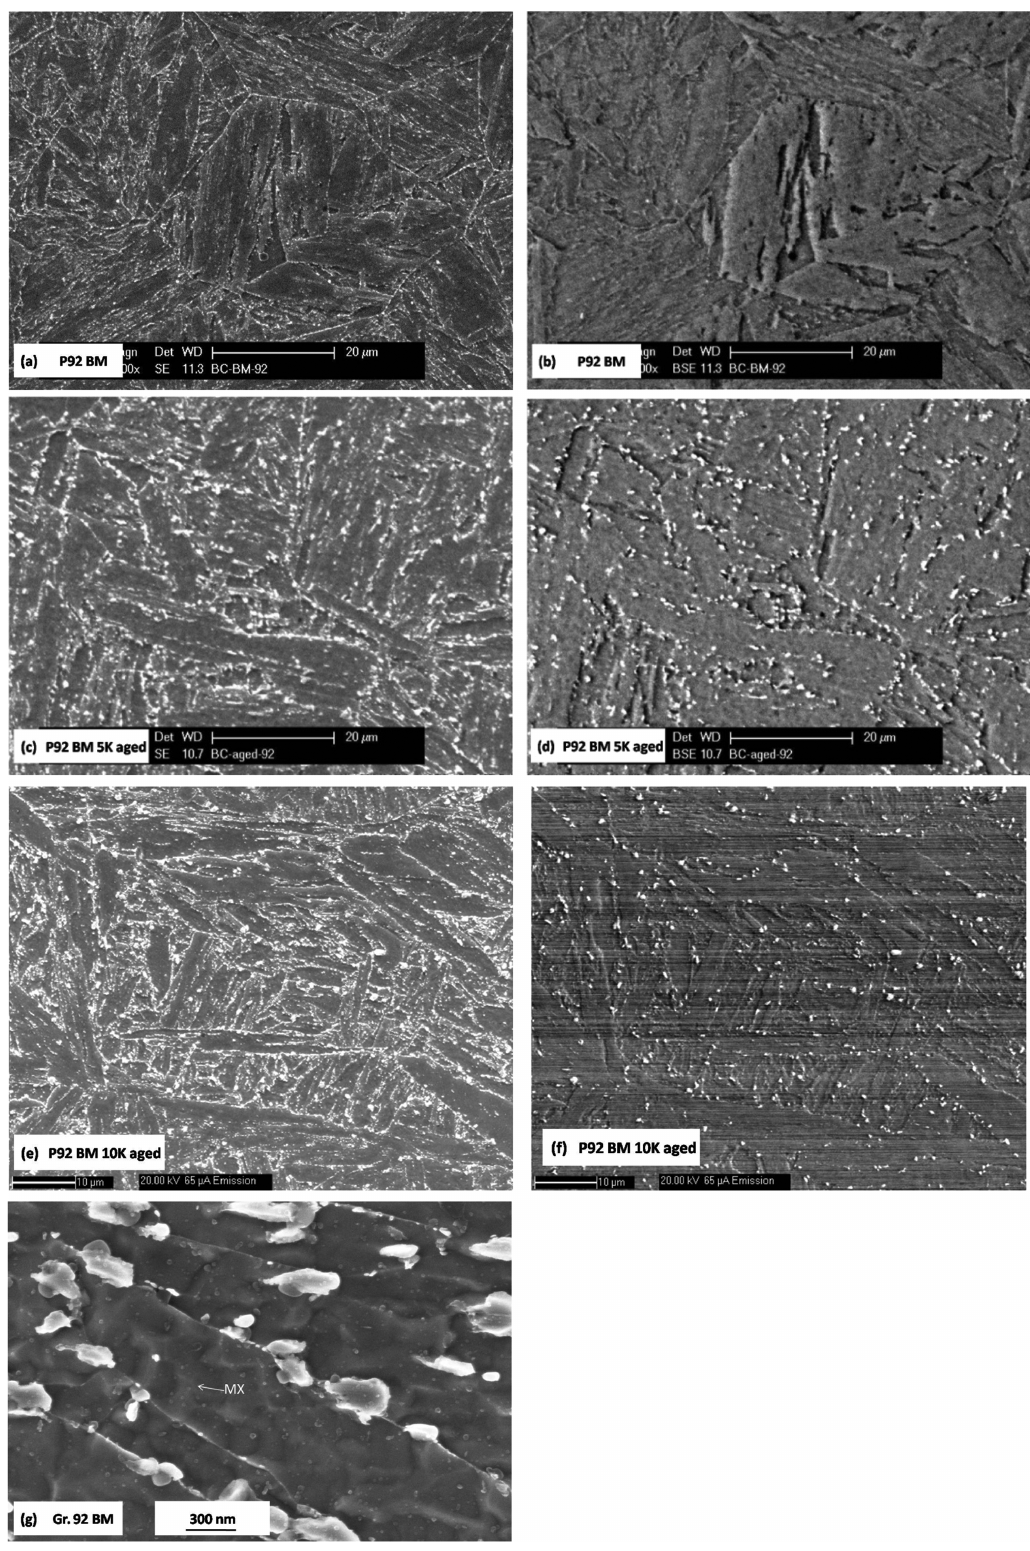
Figure 1: SEM-SE/BSE micrographs of P92 steel in the normalized and tempered (a) SEM-SE and (b) SEM-BSE mode, and thermal aged at 923 K for 5000 h (c) SEM-SE and (d) SEM-BSE mode, and 10,000 h (e) SEM-SE and (f) SEM-BSE mode, and (g) FEG-SEM micrograph of the normalized and tempered P92